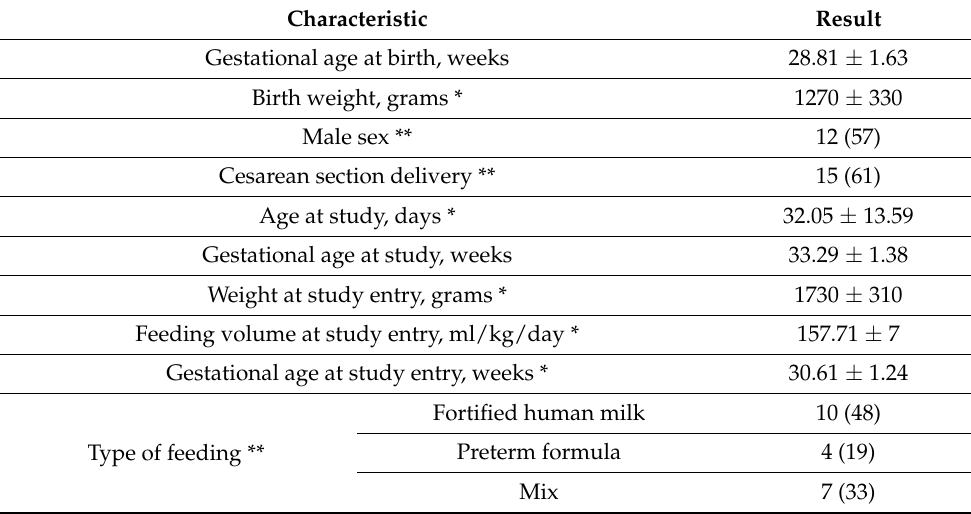
Table 1. Clinical characteristics of infants in the study group (N = 21).